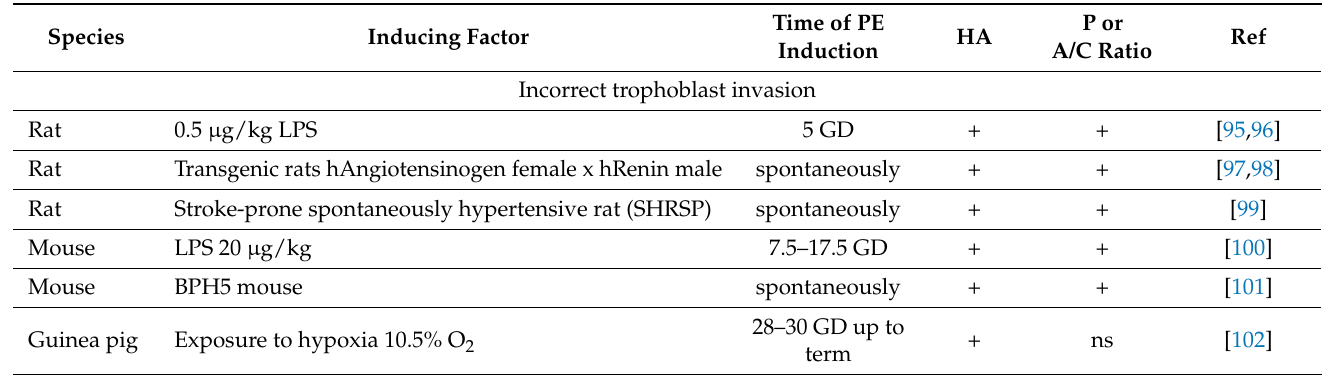
Table 1. The generation of preeclampsia by the induction of various aspects of the disease in animal